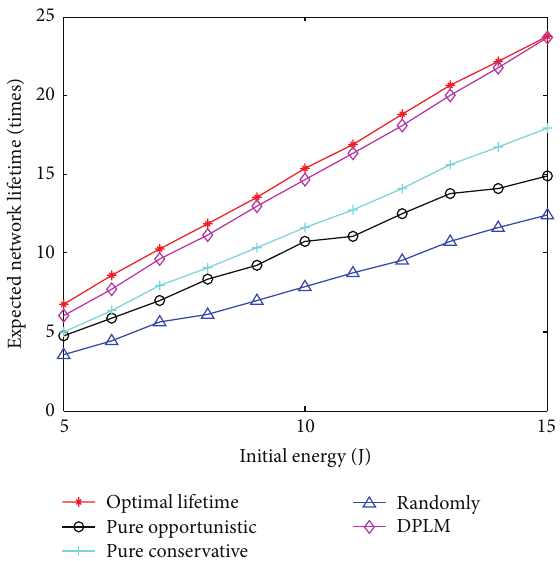
Figure 2: Expected lifetime for optimal lifetime, pure opportunistic, pure conservative, randomly, and DPLM